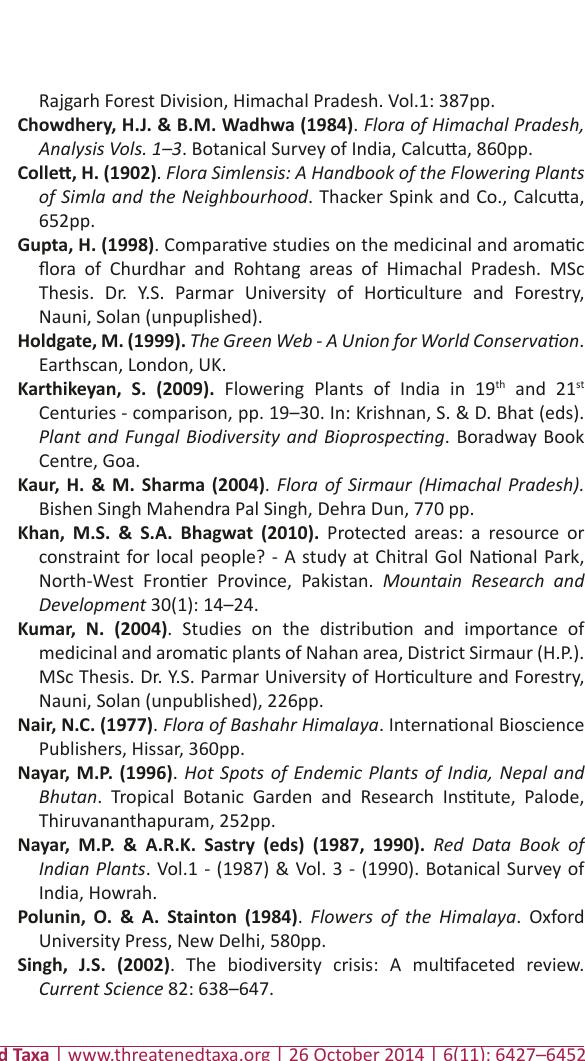
Figure 2. Ten dominant families with respect to species of the additions to the flora of Sirmaur District, Himachal